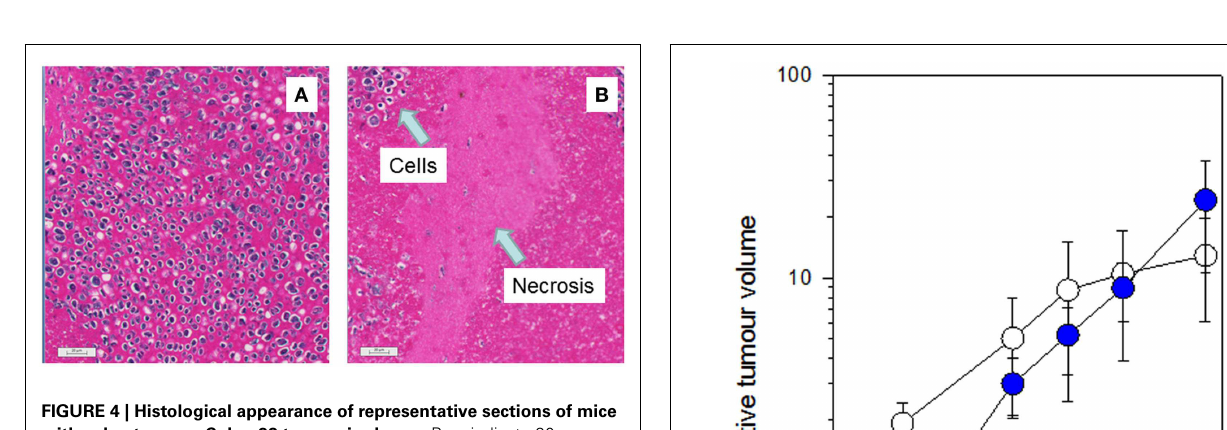
FIGURE 4 | Histological appearance of representative sections of mice with subcutaneous Colon 38 tumors is shown . Bars indicate 20 µ m. (A) No treatment: intact cells can be seen by purple nuclei with occasional pink spaces indicating necrosis. (B) Twenty-four hours after i.p. administration of vitamin C (4g/kg): the large rather featureless pink regions indicate areas of hemorrhagic necrosis.